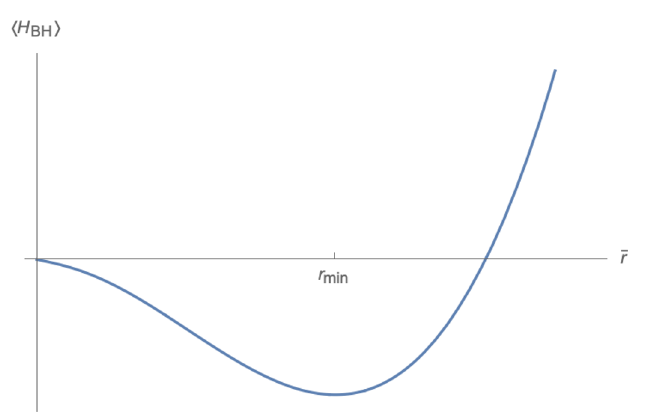
Figure 5 . Expectation value of the Hamiltonian (4.11) in the two-disconnected black holes phase for different values of ¯ r . The minimum is located at r min , which is given in (4.15).